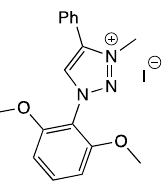
Figure 4. Cavity-free 11 used to rank the triazolium salts 1 and 2 .